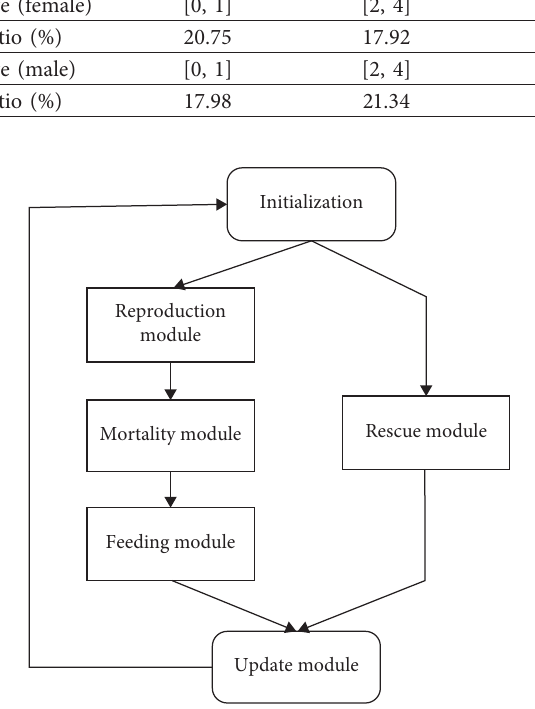
Figure 2: A conceptual model